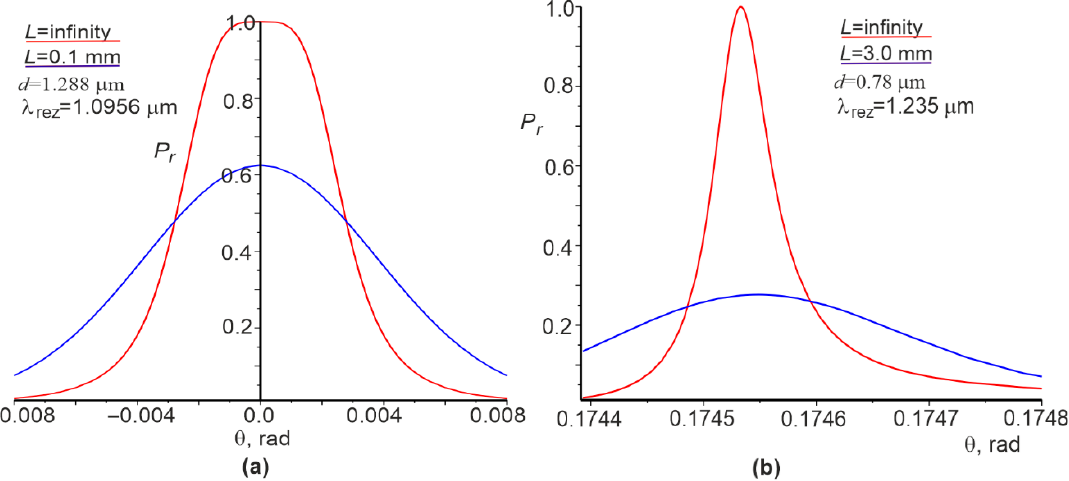
Figure 4. Angular dependences of the reflection coefficient P r at normal incidence ( a ) and the incidence angle of π /18 ( b